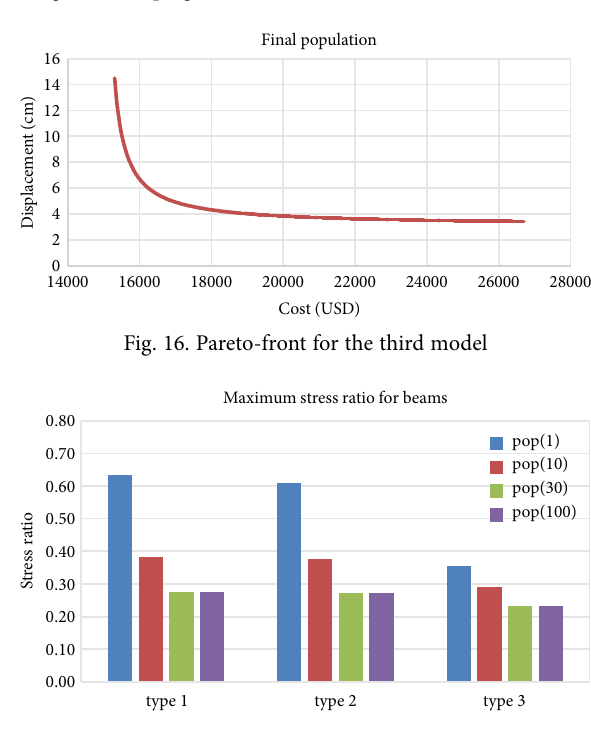
Fig. 17. The stress ratio of beams for the third model